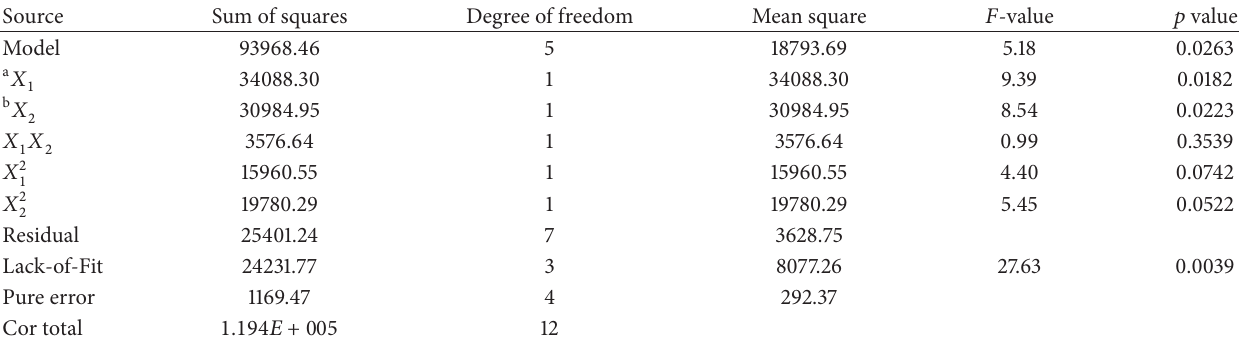
Table 6: Analysis of variance for N uptake using CCD.